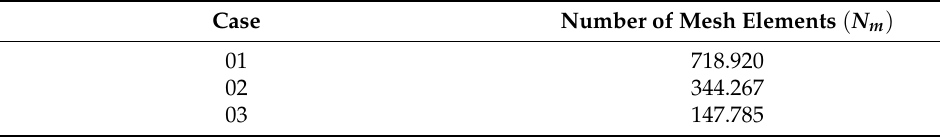
Table 3. Simulated cases for the GCI analysis.